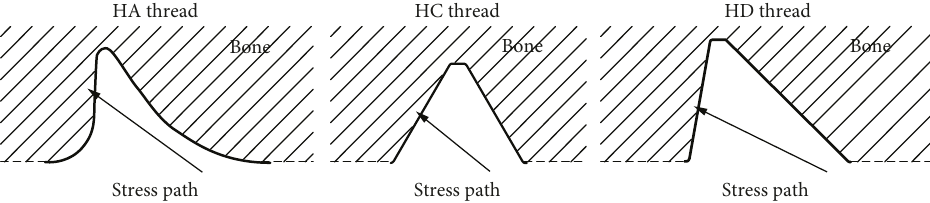
Figure 5: Stress paths to de fi ne stress pro fi les at thread-bone